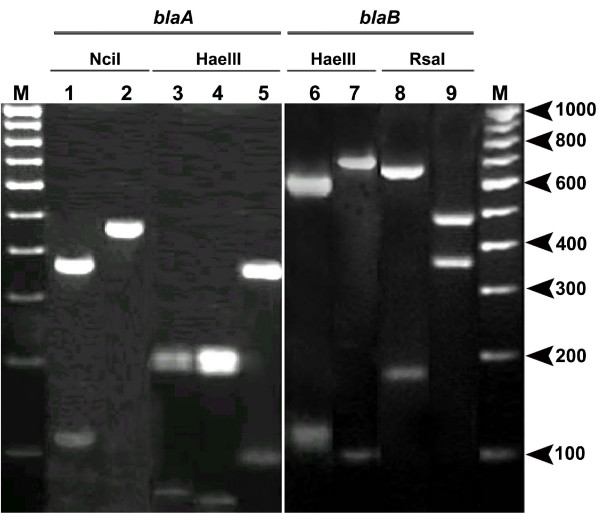
Types of restriction profiles of blaA with NciI (Lanes 1–2) and HaeIII (Lanes 3–5), and blaB with HaeIII (Lanes 6–7) and RsaI (Lanes 8–9). PCR amplification and restriction analysis were carried out for 49 strains of Y. intermedia and Y. frederiksenii. M, molecular weight DNA marker (100 bp DNA ladder)